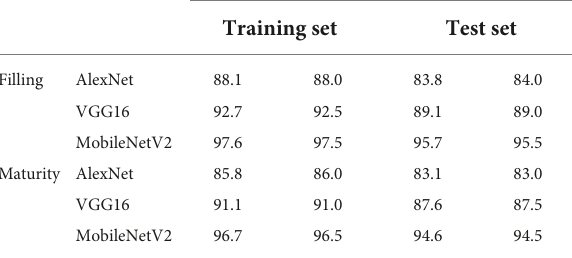
TABLE 3 Classification accuracy (%) of wheat field lodging degree based on different